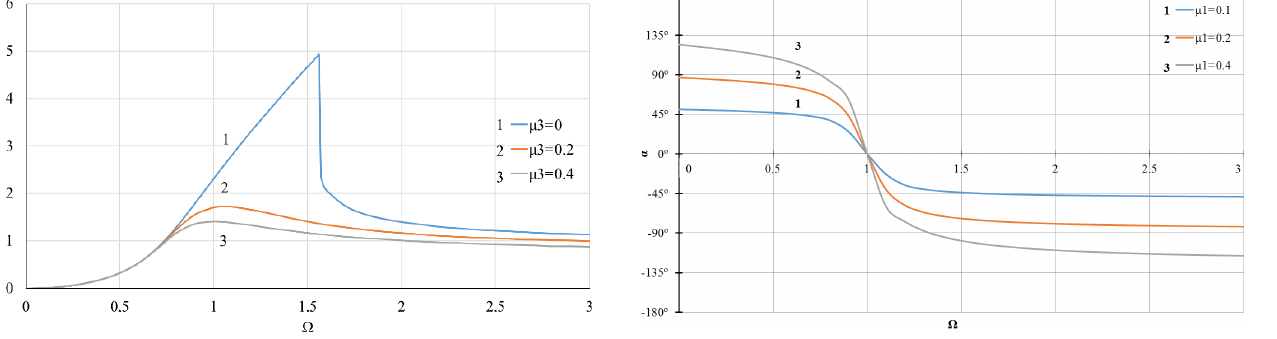
Figure 14. Dependence of the vibration phase α on the rotor speed (cid:127) with linear stiffness of the support and at different values of the coefficient of linear viscous damping µ 1